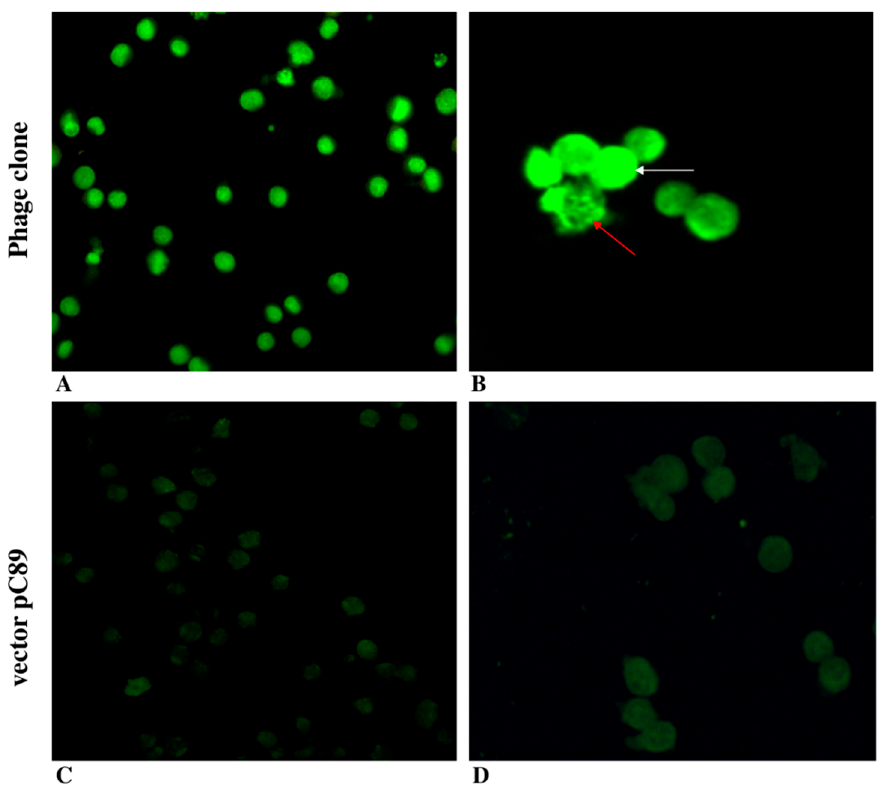
Figure 1. Validation of phage clones by fluorescence microscopy. Fluorescence imaging of MM.1 cells incubated with ARKMNPPAG FITC-labelled phage (magnification 40 × , ( A ), and 63 × , ( B )) and insert-less vector pC89 (magnification 40 × , ( C ), and 63 × , ( D )). Phage clones were found to specifically bind the MM cells line, as seen by the bright green fluorescence of FITC (Figure 1A,B) compared with the absence of fluorescence when the pC89 vector insert-less was used (Figure 1C,D). These findings indicate that the binding specificity was due to the foreign peptides displayed by phage clones, and the amine-reactive fluorochrome in the major coat protein, pVIII, did not modify the phage’s ability to bind the MM.1 target cells. However, we observed a different phage